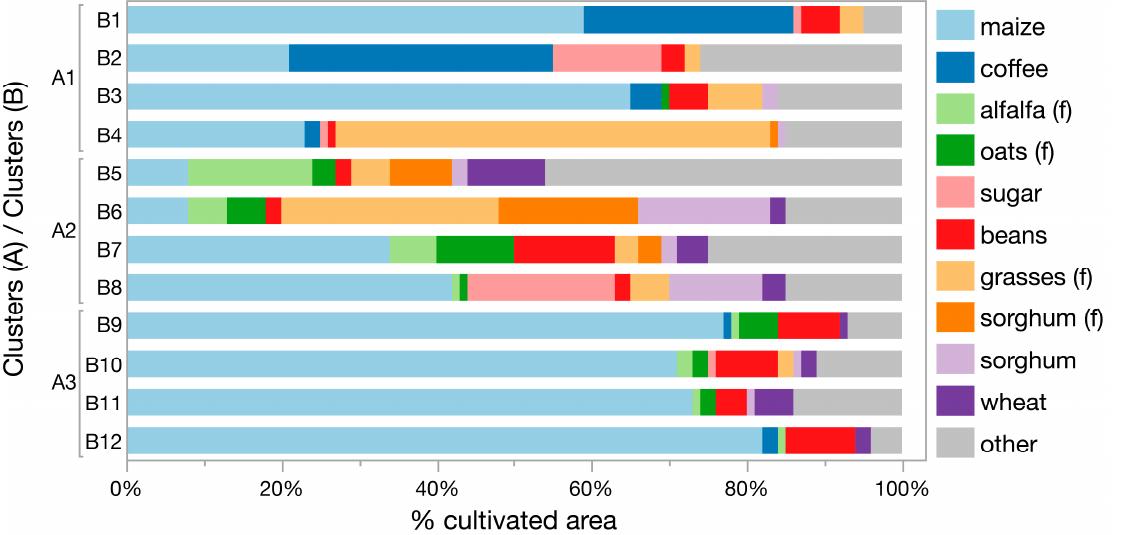
Figure 3. Mean % of cultivated area with each crop per cluster (B1–B12).